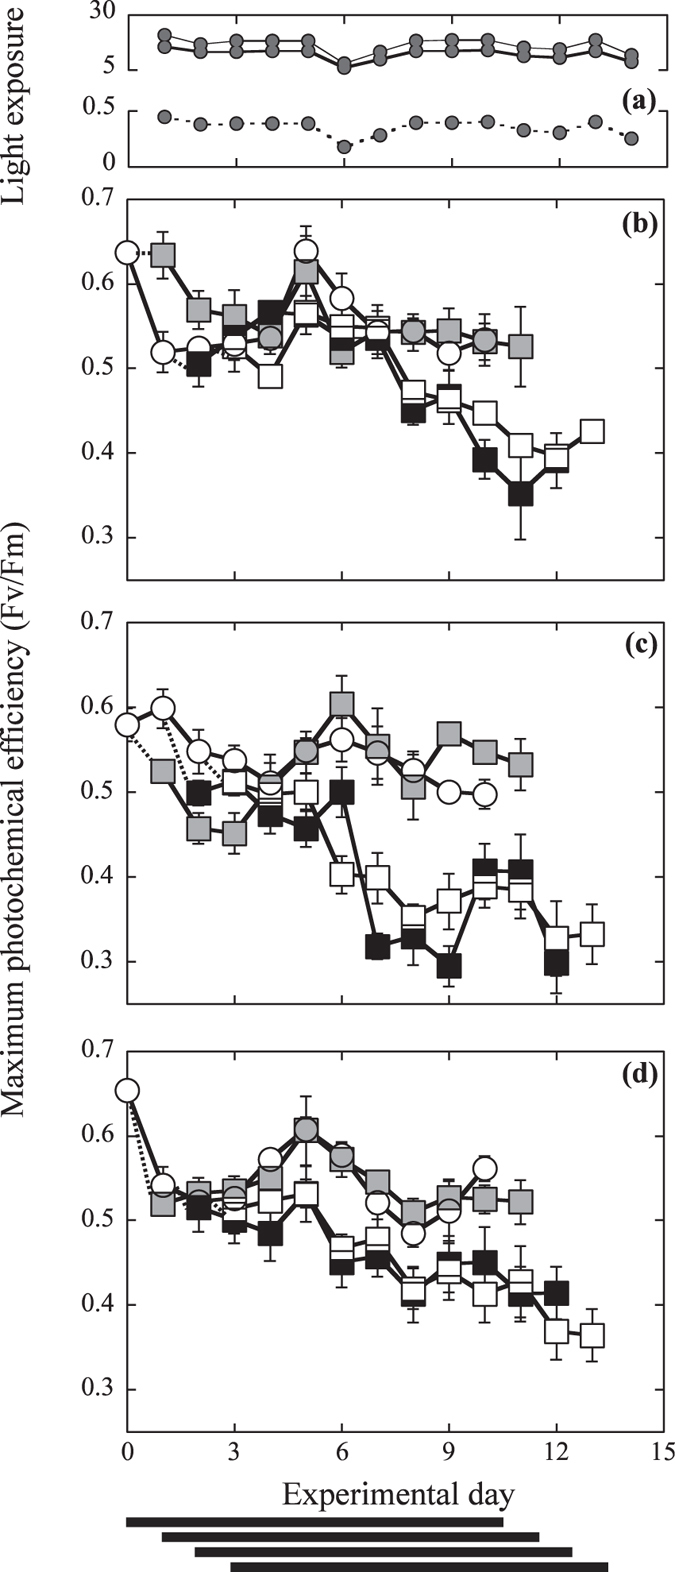
Variation in solar radiation and Fv/Fm during the experiment.(a) The variation in daily light exposure (mol quanta m−2 d−1) and maximum photochemical efficiency of photosystem II, Fv/Fm, measured at dusk daily for rhodoliths (b), articulated alga (c) and CCA (d). Lines in (a) are grey for rhodoliths, black for the articulated alga, and dashed for CCA. Symbols in (b–d) are white circles for control treatments (ambient pH and 30 °C), grey squares for the low pH treatment (pH 7.9 and 30 °C), black squares for the thermal stress treatment (ambient pH and +2 °C [32 °C]), and white squares for the interaction between thermal stress and reduced pH (pH 7.9 and +2 °C [32 °C])). The dashed lines in (b–d) indicate Fv/Fm values before the initiation of the corresponding treatment. The black horizontal bars at the bottom of the figure illustrate the beginning and end of each 10-day treatment. The symbols represent mean values ± SEM (n = 4–10 per experimental day).